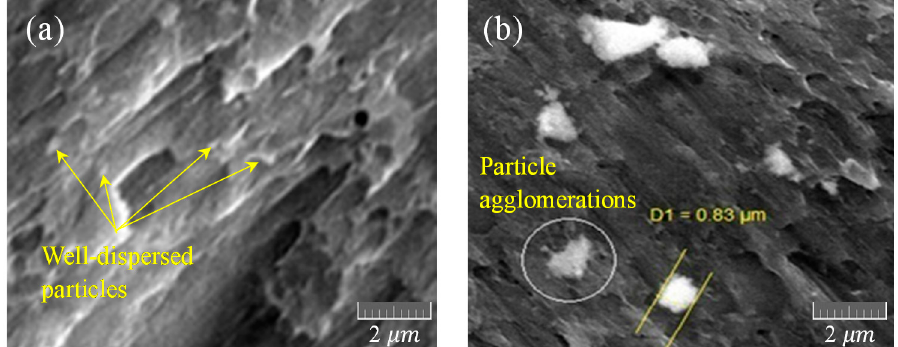
Figure 10. SEM images of distribution of alumina powder in aluminum 7075-T6 after FSSW procedure in: ( a ) the joint containing 1 wt.% alumina particles; ( b ) the joint with 2.5 wt.% alumina particles.